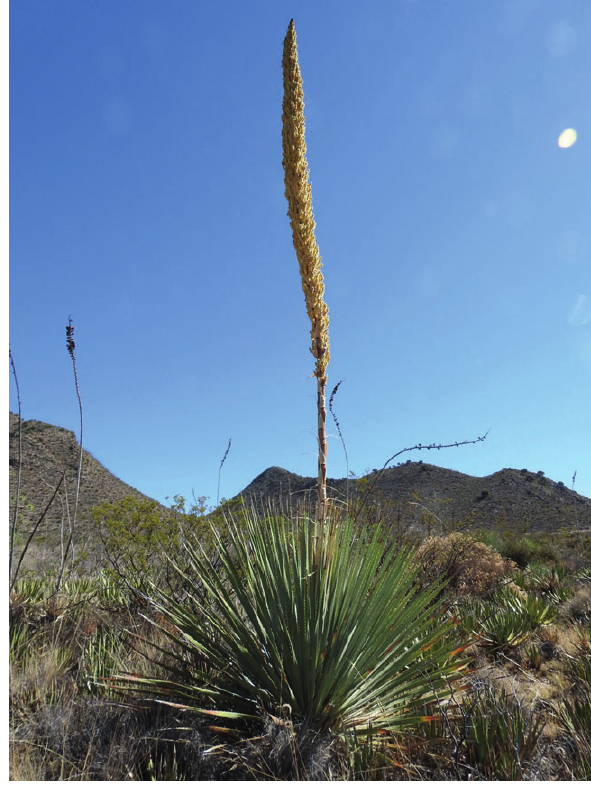
Figure 1. Dasylirion cedrosanum Trel. (Photograph by Arturo Cruz Anaya,